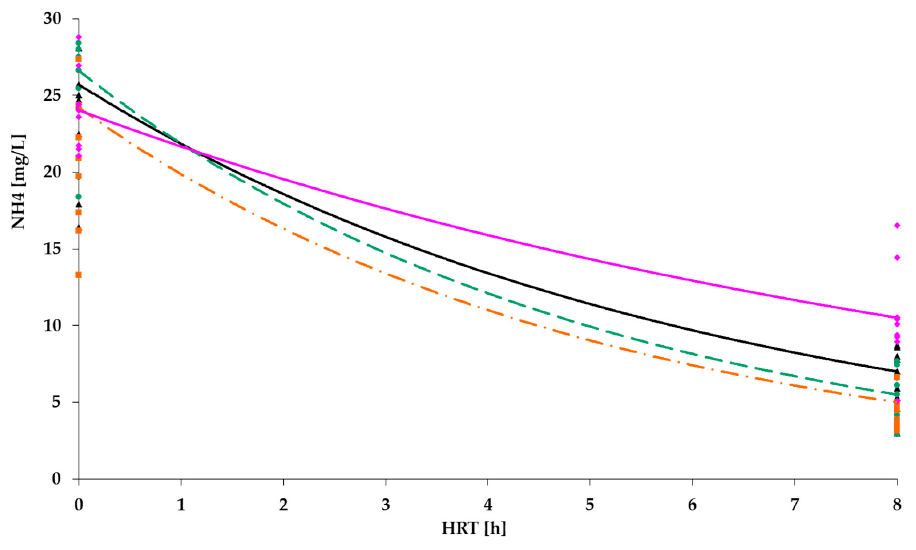
Figure 11. Ammonium removal dynamics if: floating carrier PV is 10% of reactor volume (black); 20% of tank volume (green); 30% of tank volume (orange); no carrier in the reactor (magenta). Table 3. Average values of treatment for PV-carrier.